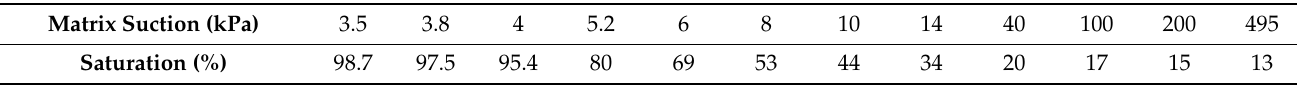
Table 2. Correspondence between the matrix suction and saturation of sand specimens.